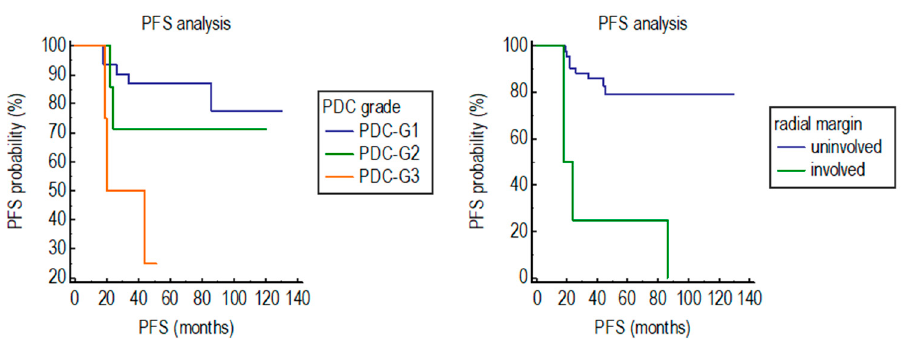
Figure 4. Impact of PDC grade assessed in the pre-treatment endoscopic biopsy and involvement of radial margin in the surgical specimen on the PFS of patients with rectal carcinoma treated with neoadjuvant chemo-radiotherapy and surgery.